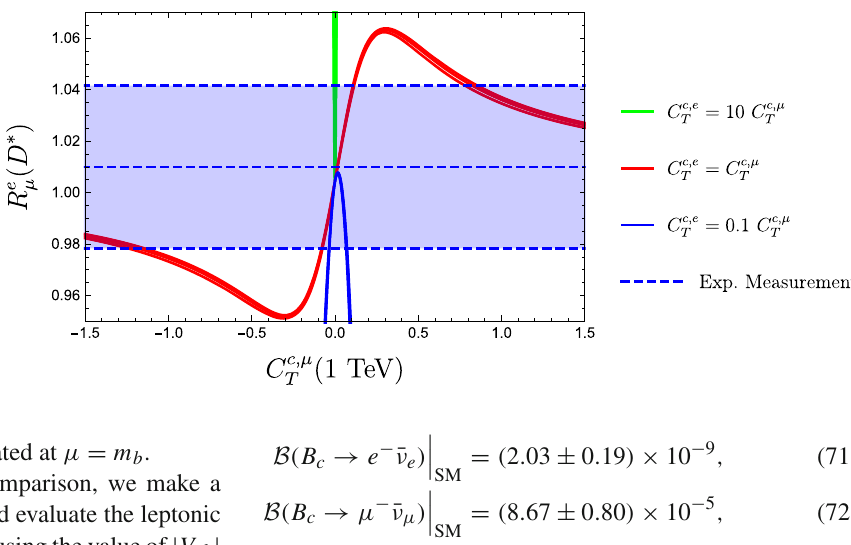
Fig. 16 Constraints in the C c ,τ ,μ C c , e and C c T T